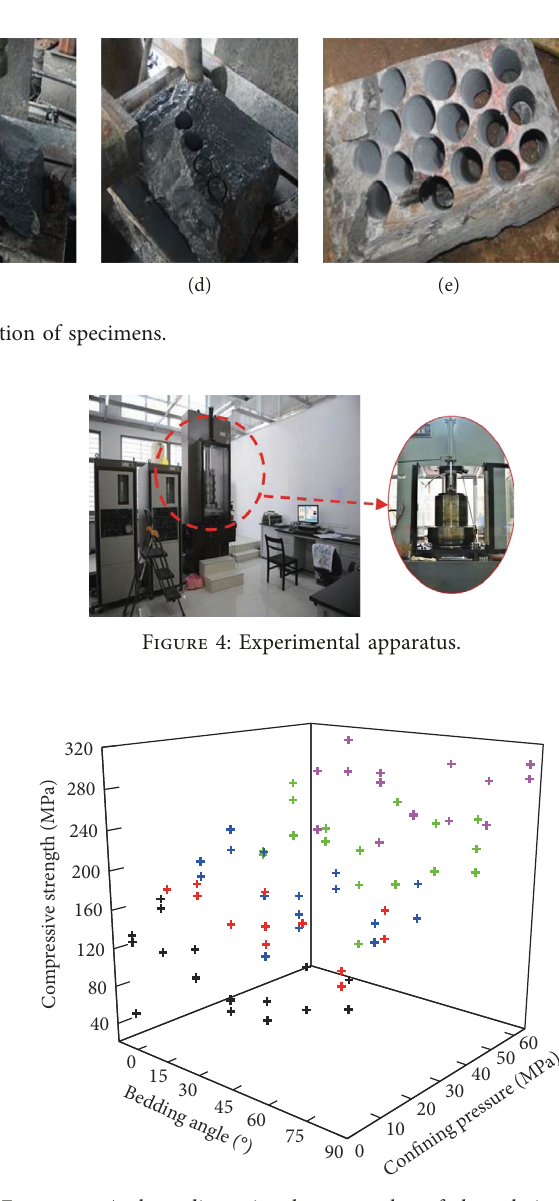
Figure 5: A three-dimensional scatter plot of the relationship between compressive strength, confining pressure, and bedding